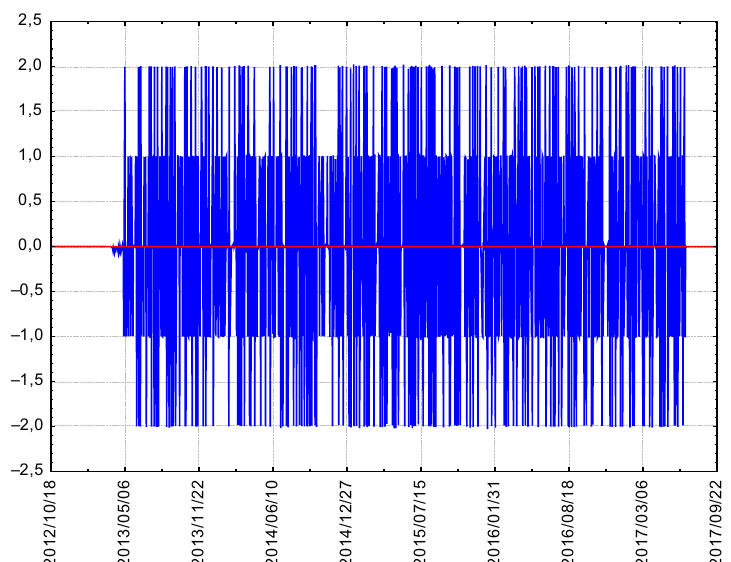
Figure 6. The conditional volatilities of the Brent oil futures in the presence of OPEC news over the period from April 01, 2013 to